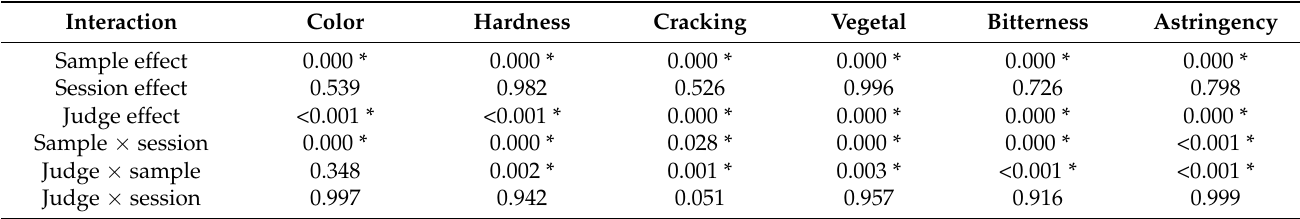
Table 4. Three-way ANOVA results for the evaluation of sensory panel